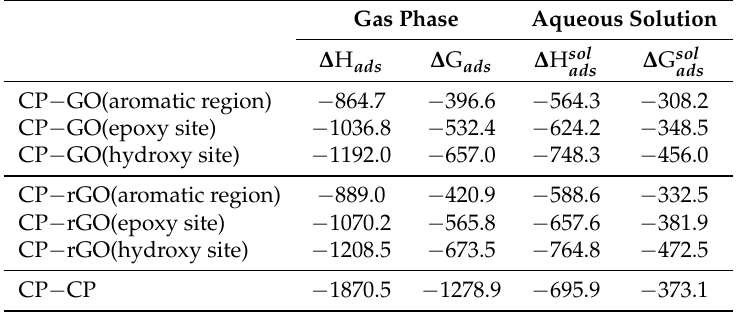
Table 4. Enthalpy ( ∆ H ads ), and free energy ( ∆ G ads ) variations for the physisorption of CP on GO supports and the related extrapolations for rGO. ∆ H ads and ∆ G ads refer to 298.15 K and 1 bar and have been obtained by assuming rigid rotor and harmonic frequency approximations through PBE-D3 (BJ) calculations by considering the carbon support as a rigid structure. Extrapolated values for the adsorption on rGO are obtained by scaling the adsorption enthalpies using the interaction energies computed for C 54 H 18 and C 96 H 24 (see text and Table 2). Corresponding values for the CP dimerization are also reported for comparison. The aqueous solution (sol) results refer to geometry optimizations carried out by using the SMD continuum solvation model. All values are in meV (1 kcal/mol = 43.37